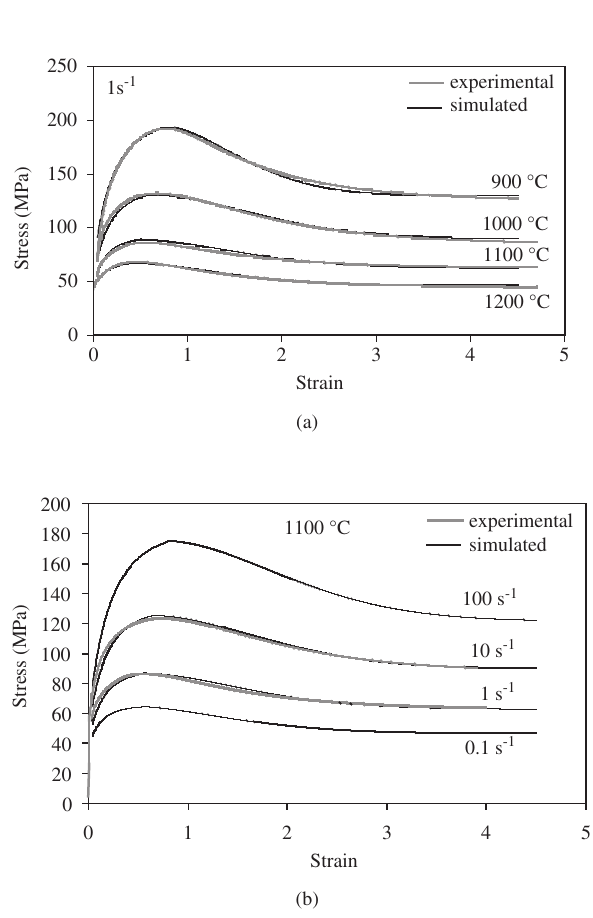
Figure 5. Experimental and simulated flow stress curves determined with strain rate of 1 s -1 a) and determined at 1100 °C with strain rates of 1 and 10 s -1 and predicted for strain rates of 0.1, 1, 10 and 100 s -1 b).